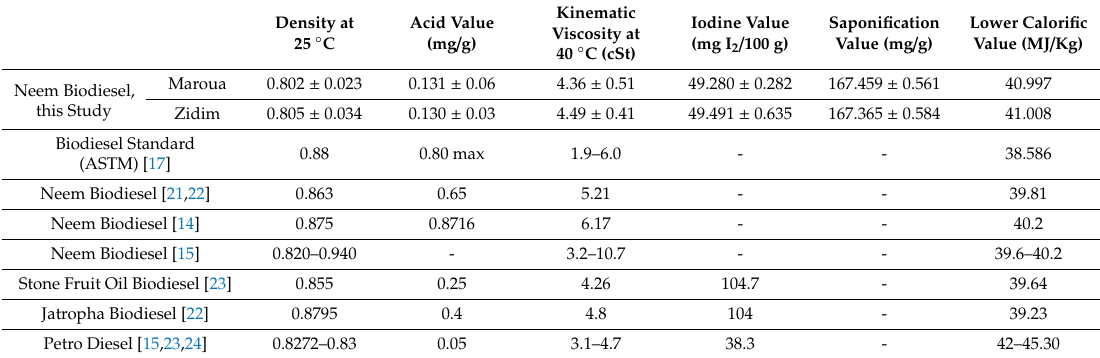
Table 4. Comparison of the biodiesel produced with other biodiesel, standard biodiesel and petrodiesel.